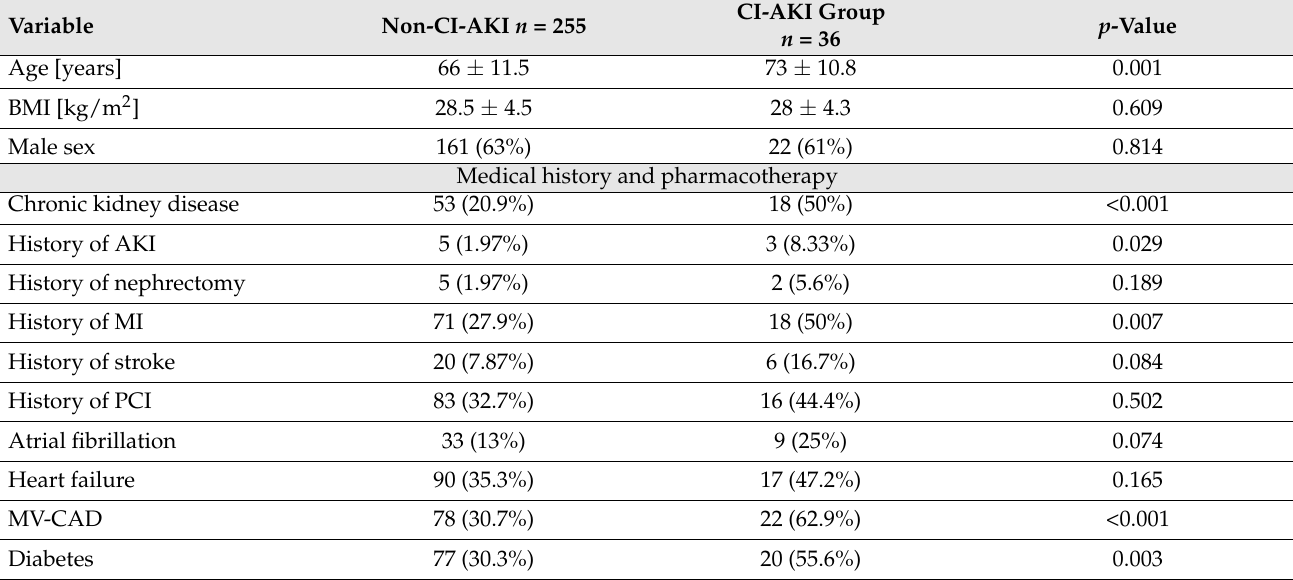
Table 2. Demographic and clinical characteristics of non-CI-AKI and CI-AKI groups.